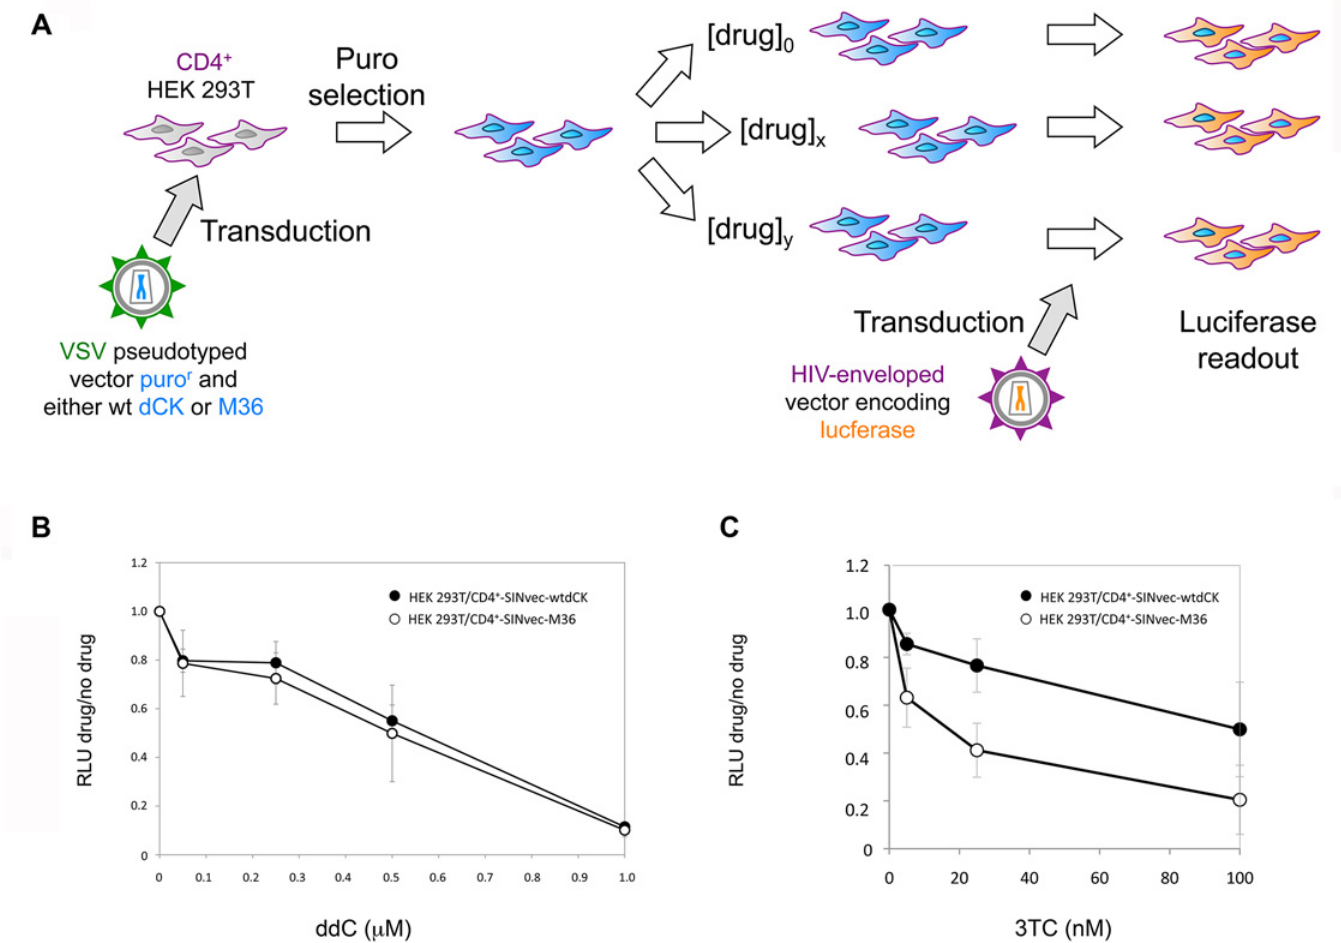
Fig 6. M36 and sensitisation to anti HIV drugs. Panel A. Schematic representation of the experimental procedure used to test the level of resistance to infection by HIV-derived vectors of cells expressing constitutively M36 and treated in the presence of the anti-HIV compounds ddC and 3TC. Panels B and C. Sensitivity to transduction with HIV-derived vectors in the presence of varying concentrations of ddC (panel B), or 3TC (panel C), of HEK 293T-CD4+ cells encoding M36 (white circles), or an extra copy of the wt dCK gene (black circles). Data are the average of 3 independent experiments. RLU, relative luciferase